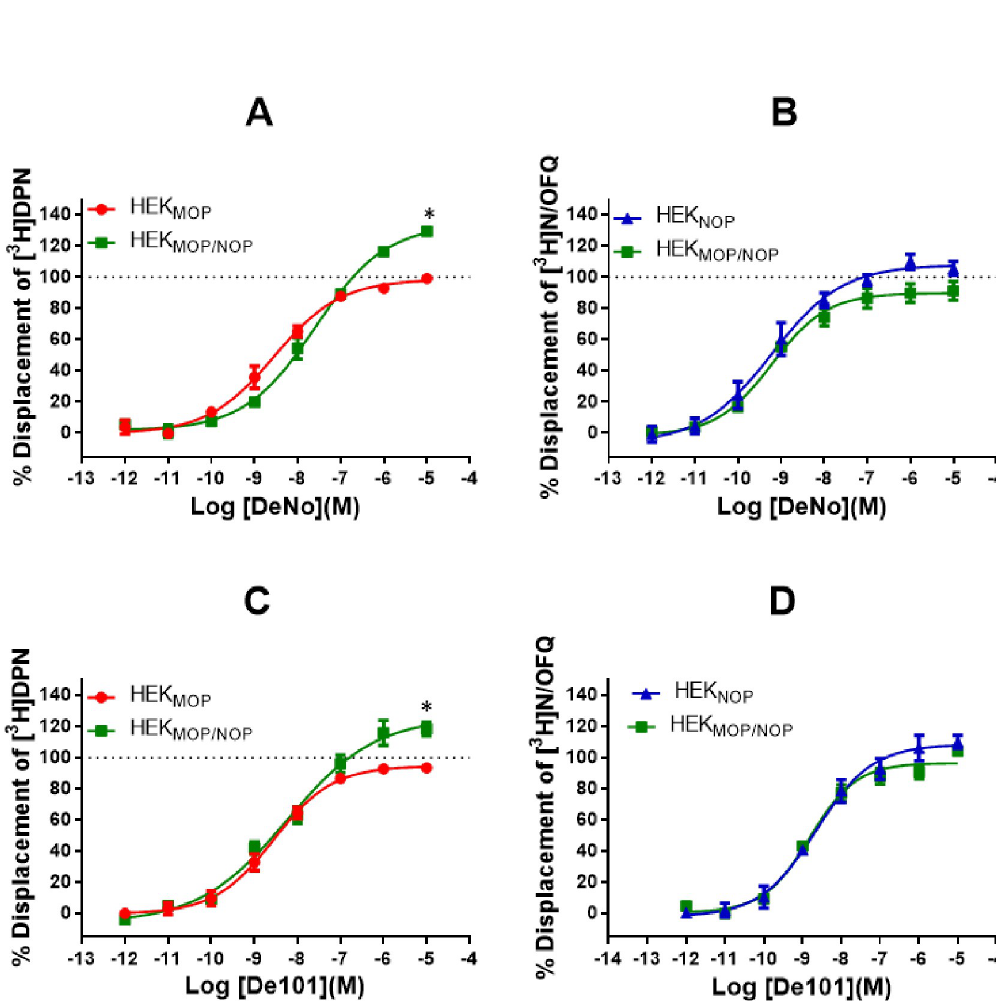
Fig 5. Displacement binding curves of A) DeNo in HEK MOP and HEK MOP/NOP cell membranes against [ 3 H]-DPN or B) in HEK NOP and HEK MOP/NOP cell membranes against [ 3 H]-N/OFQ. Displacement binding curves of C) De101 in HEK MOP and HEK MOP/NOP cell membranes against [ 3 H]-DPN or D) in HEK NOP and HEK MOP/NOP cell membranes against [ 3 H]-N/OFQ. Data are the mean ( ± SEM) of n = 5 experiments.